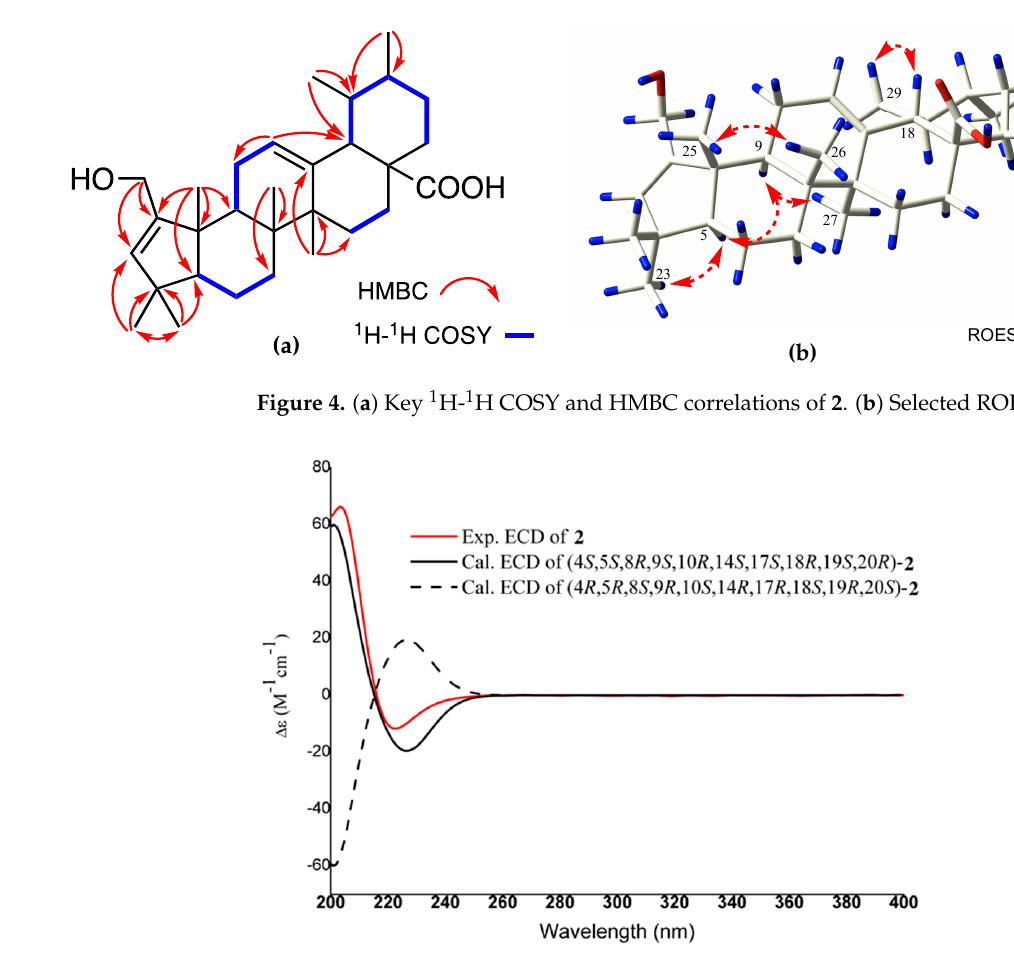
Figure 5. Experimental and calculated ECD spectra of 2.